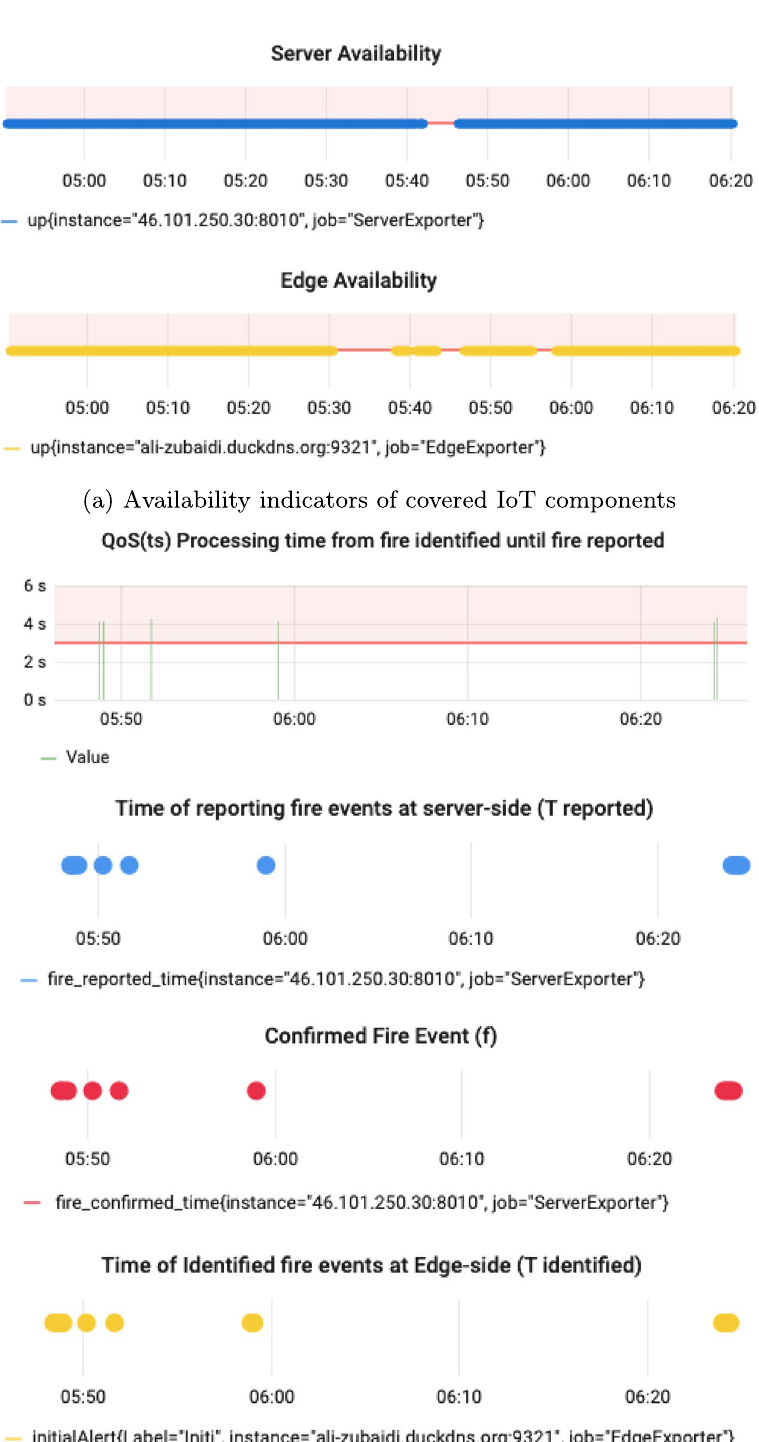
Fig. 12 A screenshot of metric collection and Incident